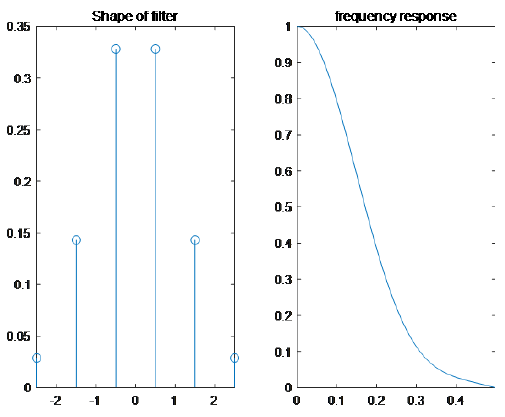
Figure 7. The shape of the FIR filter and the frequency